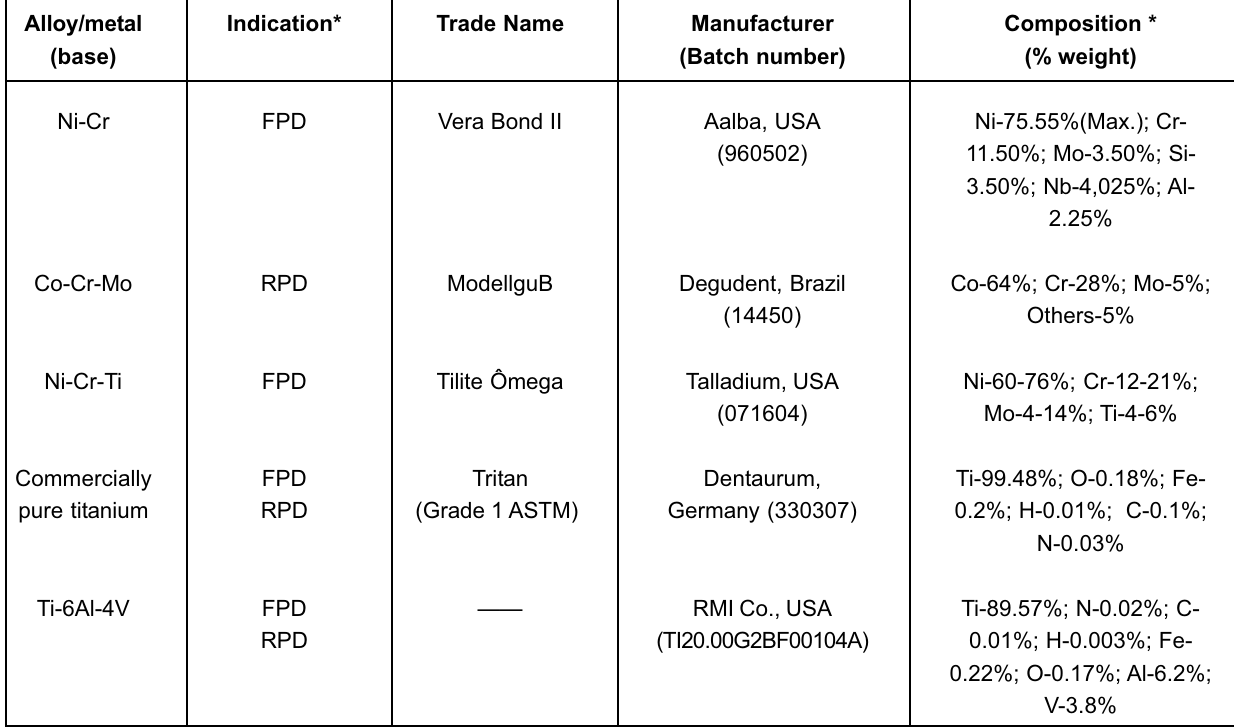
FIGURE 1- Alloys and metals evaluated with their indications, trade names, manufacturers, batch numbers and chemical